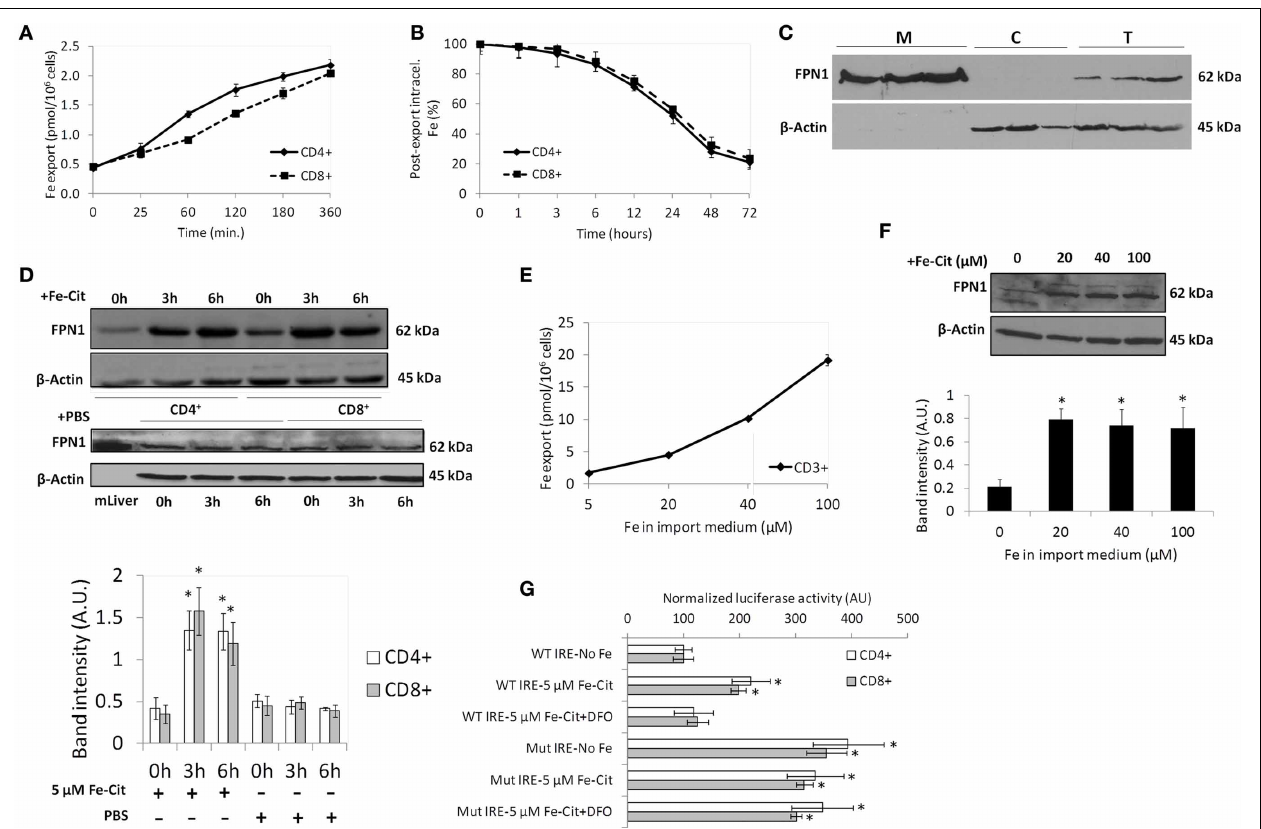
FIGURE 3 | Iron export by T lymphocytes. (A) Time-dependent iron export by T lymphocytes. Each point is a mean value ( n = 3) ± 1 SD. (B) Impact of iron export in intracellular Fe levels. Each point is a mean value ± 1 SD of two experiments each with three replicates. (C) Ferroportin (FPN1) expression in CD3 + T lymphocytes. Membrane (M), cytoplasmic (C), and total (T) extracts of CD3 + cells were blotted and membranes incubated with anti-FPN1 and anti- β -actin antibodies. Results obtained with CD3 + cells from three different blood donors are presented. (D) Western blot quantification of FPN1 expression in CD4 + and CD8 + T lymphocytes incubated with 5 μ M of Fe-citrate (upper panel) or PBS (middle panel) for 0–6h. β -actin expression was used as loading control. Images are representative of four experiments without significant inter-experimental variation. Bottom panel: Scanning densitometry of FPN1 Western blots. Data are normalized for β -actin levels and are expressed as arbitrary units (AU); ∗ P < 0 . 05 (One-Way ANOVA) between relative FPN1 levels at 0h and posterior time-points, for each